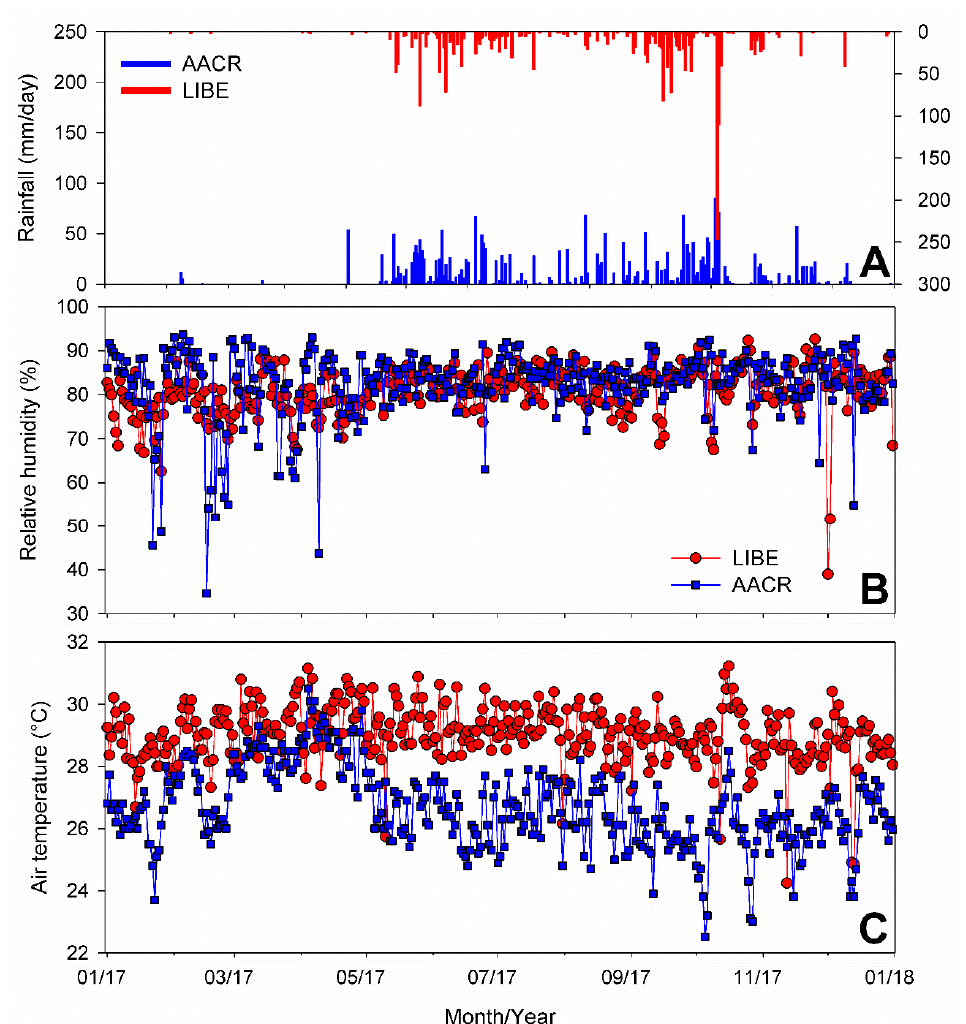
Figure 4. The time series of ( A ) the daily precipitation (mm / day) recorded in Heredia (blue bars) and in Liberia (red bars) during 2017: The left y-axis corresponds to Heredia, whereas the right y-axis shows the data of Liberia. ( B and C ) The average daily relative humidity (%) and air temperature (°C) for Heredia (blue circles) and Liberia (red circles).